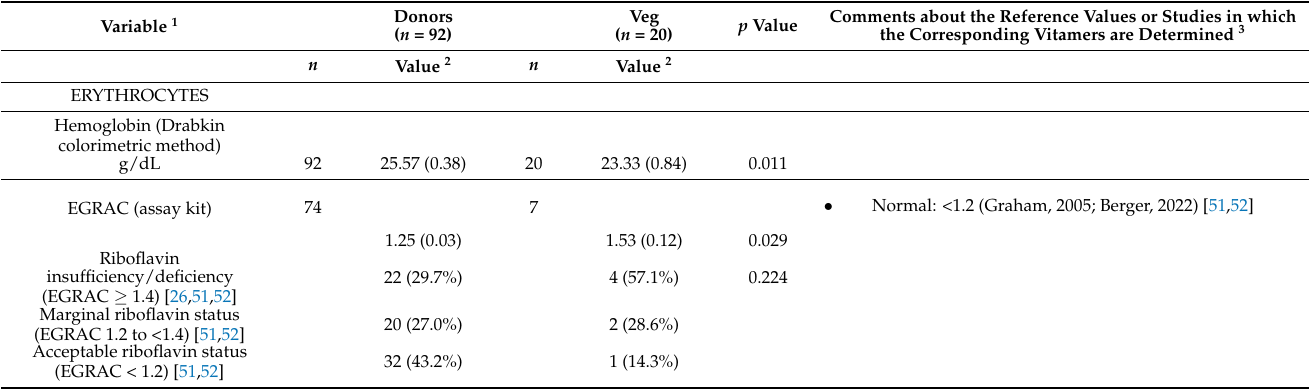
Table 10. Erythrocytes, plasma, and urine concentrations of nutrients and biochemical determinations